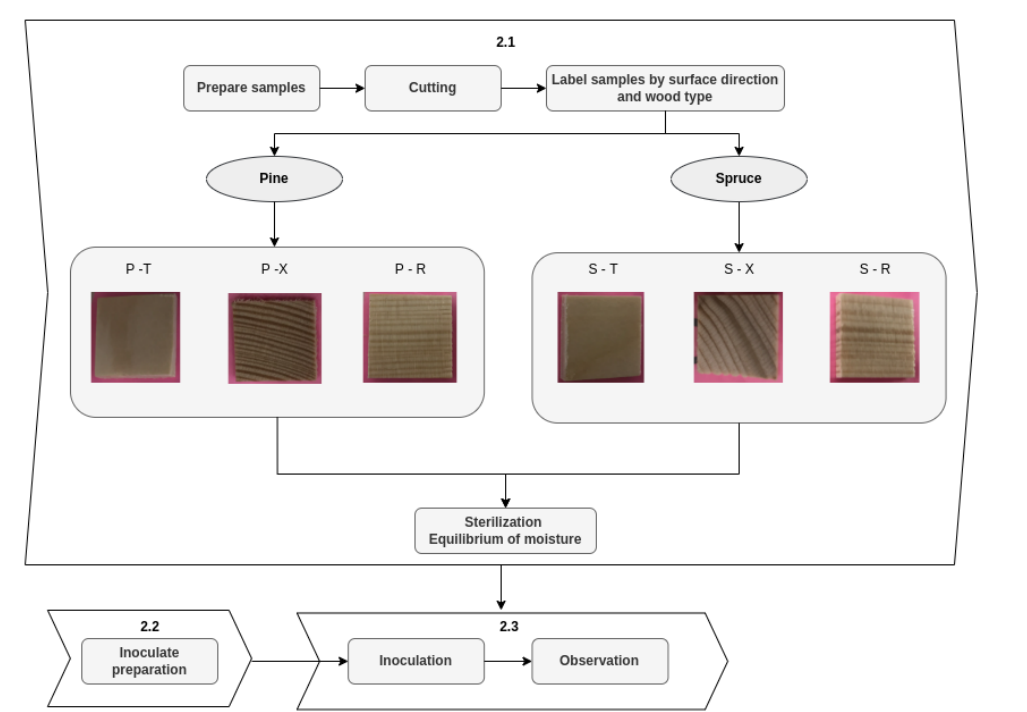
Figure 1. The description of experiment